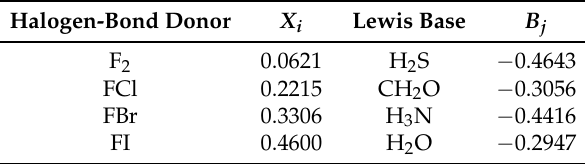
Table 2. Selected parameters for halogen-bond donors and Lewis bases as fitted to the P 4 model. The optimized value of c for this model is 3327.9474 kcal mol − 1 Å 4 , all other parameters are dimensionless. A table of all parameters can be found in the Supplementary